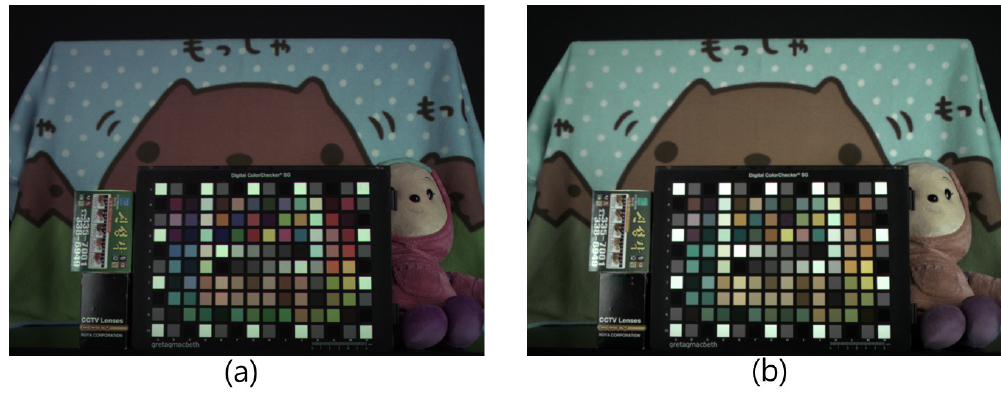
Figure 4. Color difference by use of W pixel (incandescent lamp): ( a ) Conventional Bayer CFA image; ( b ) Image obtained by RWB CFA image